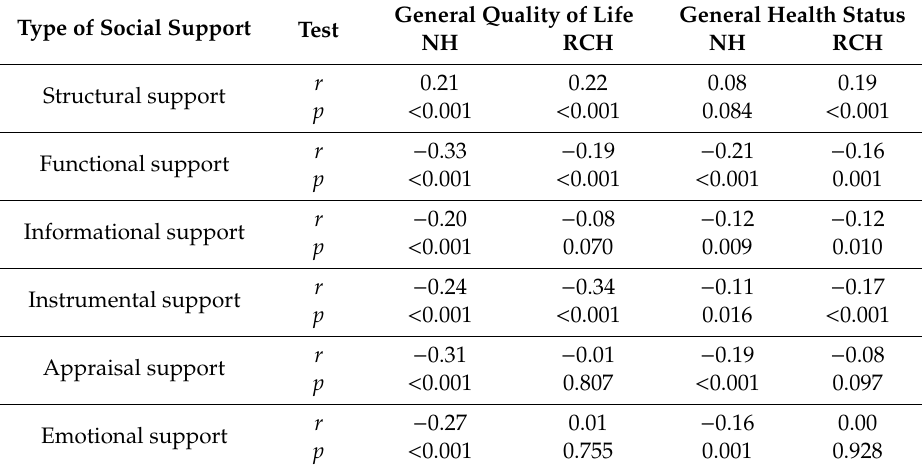
Table 2. Correlation between social support and general quality of life and health